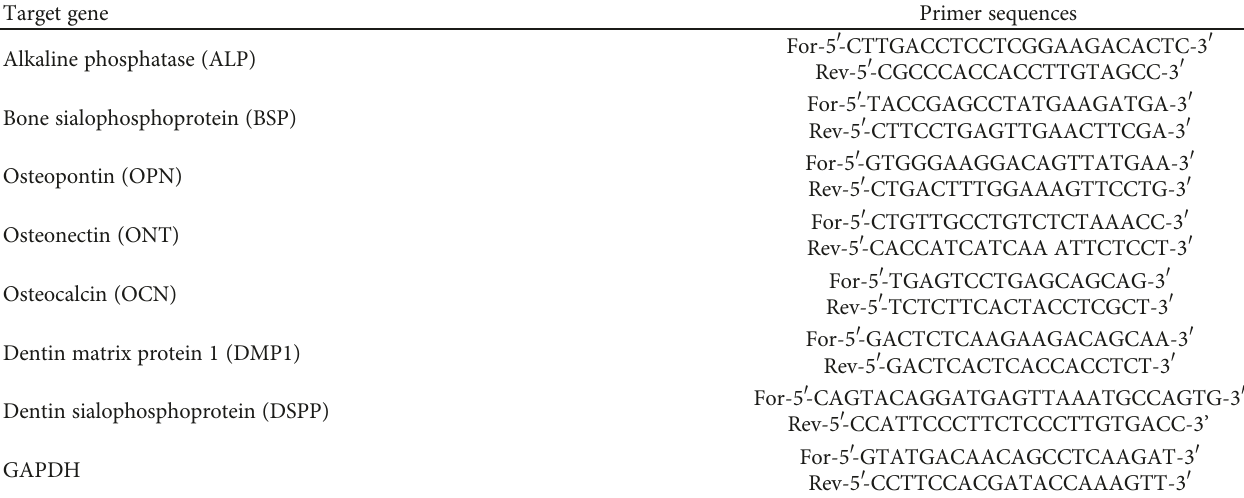
Table 1: Primers used for the quantitative real-time-PCR